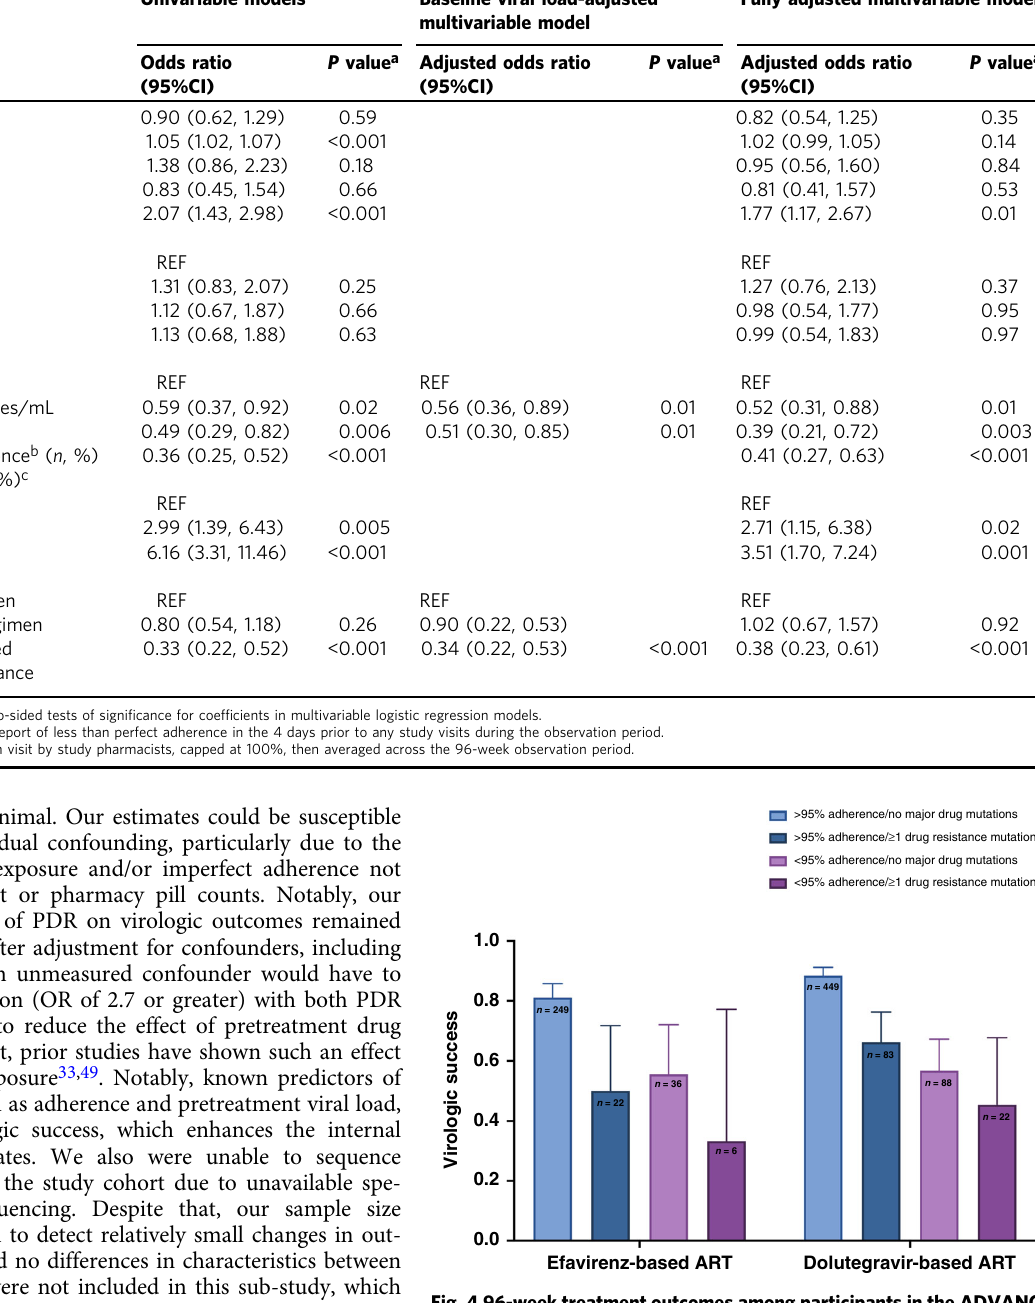
Fig. 4 96-week treatment outcomes among participants in the ADVANCE Trial divided by treatment arm, presence or absence of WHO-de fi ned pretreatment drug resistance, and achievement of greater than vs less than 95% adherence based on pharmacy pill count. Error bars represent 95% con fi dence intervals of the proportion